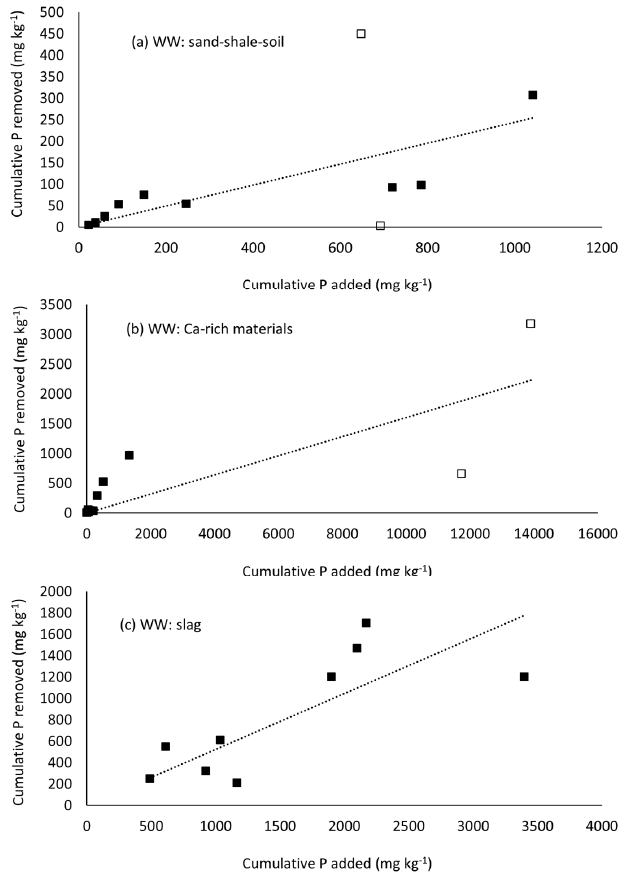
Figure 3. Cumulative P removed for studies with high dissolved P inflow concentrations and long retention time (RT), expressed as a function of cumulative P loading for the data listed in Table 1. All studies shown are for wastewater (WW) treatment with different P sorption materials (PSMs): ( a ) sand, shale, or soil; ( b ) Ca-rich materials not including steel slag; and ( c ) steel slag. Statistics are listed in Table 2. Open squares indicate highly influential points described in Table 2.